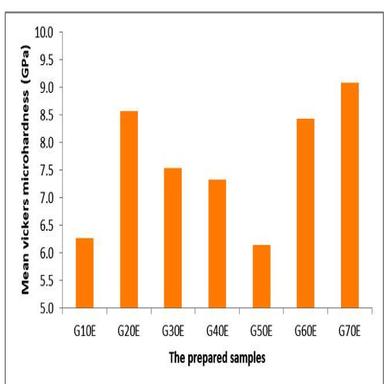
Vickers microhardness of the investigated glasses after heat- treated at550◦C, 2h and then at 800◦C, 2h